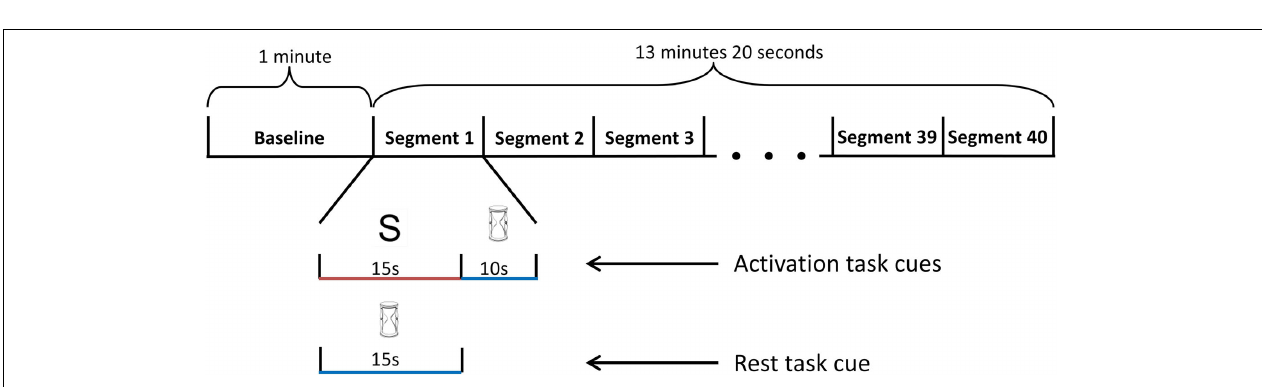
the activation mental task for 15s, followed by the rest task (visual tracking of the TCD feedback signal) for 10s. If an hourglass was displayed instead of